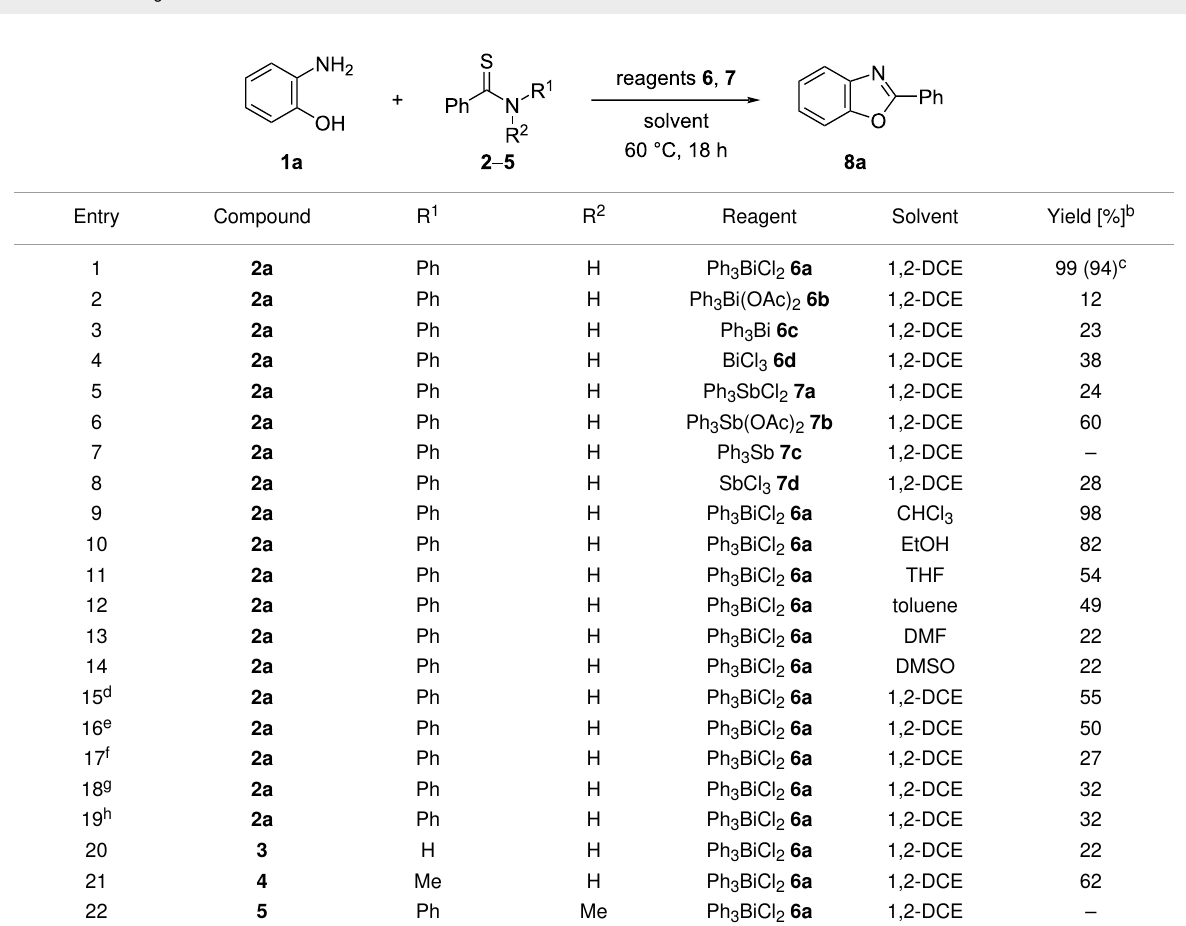
Table 1: Screening of reaction conditions a